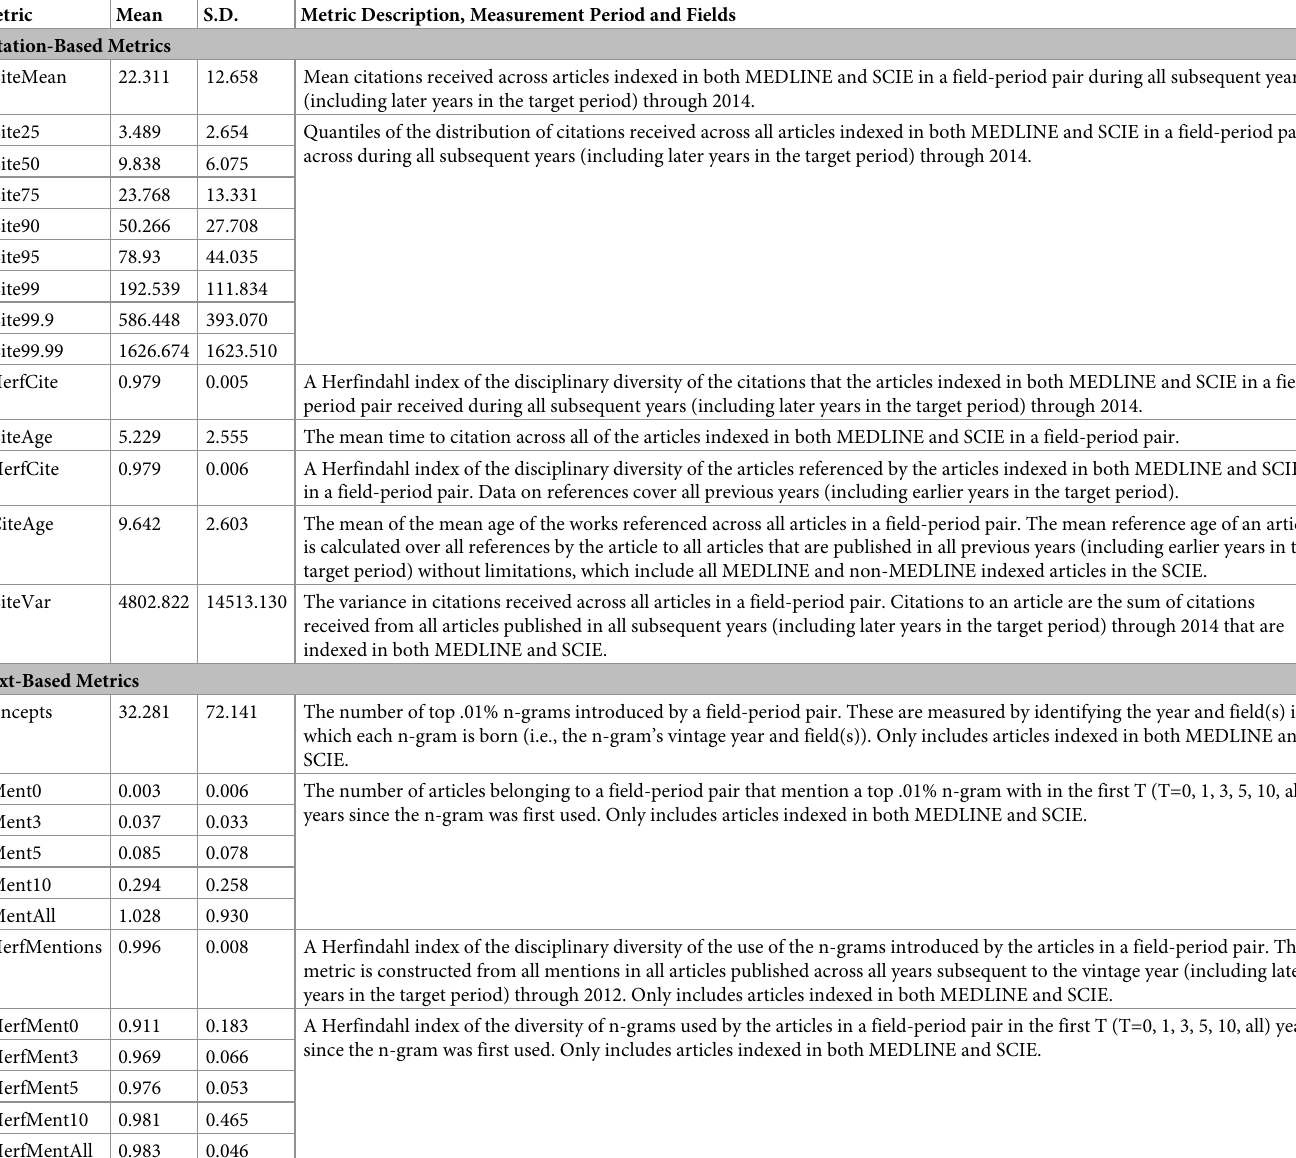
Table 3. Summary statistics for all metrics for time periods 1983–1987, ... , 2008–2012 and all MESH4 fields in